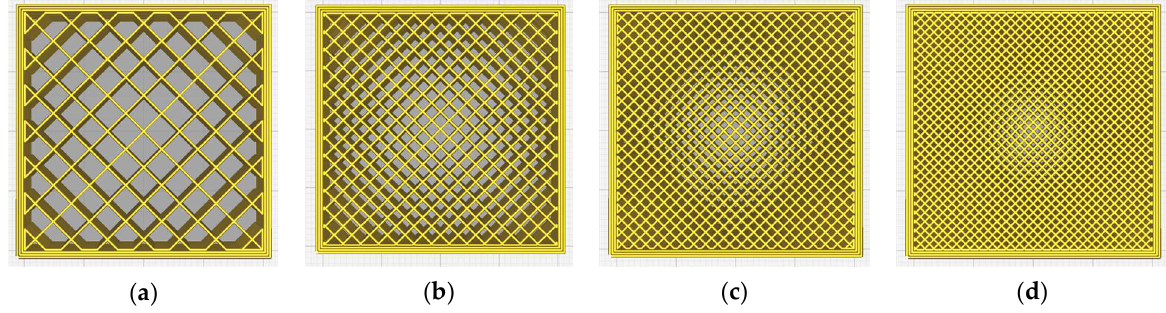
Figure 2. The perspective views of a prismatic volume (40 × 40 × 10 mm 3 ) with various infill patterns defined by 3D models: ( a ) cross 3D, ( b ) gyroid, ( c ) quarter cubic, ( d ) octet subdivision. The density of the infill indicates the percentage of the inner volume that is occupied by material (100% infill density indicates a solid volume; 0% infill density indicates a hollow part). Figure 3 shows a 40 × 40 × 10 mm 3 prismatic volume with grid infill at four different densities: 20%, 40%, 60% and 80%. The infill was generated by the Ultimaker Cura 5.0.0 slicer software, using three perimeter contours and without upper and lower layers.